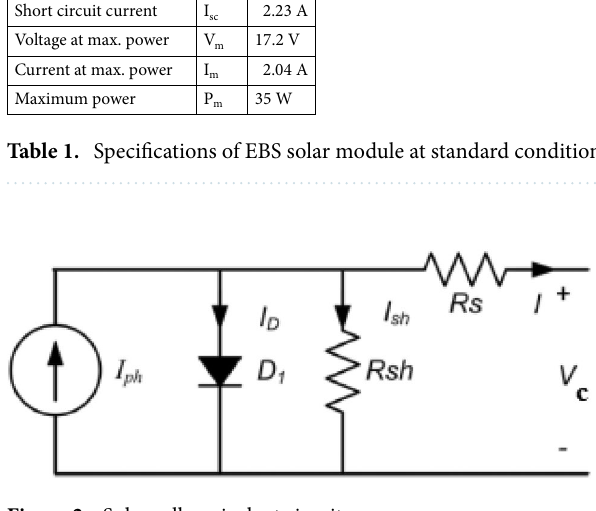
Figure 2. Solar cell equivalent